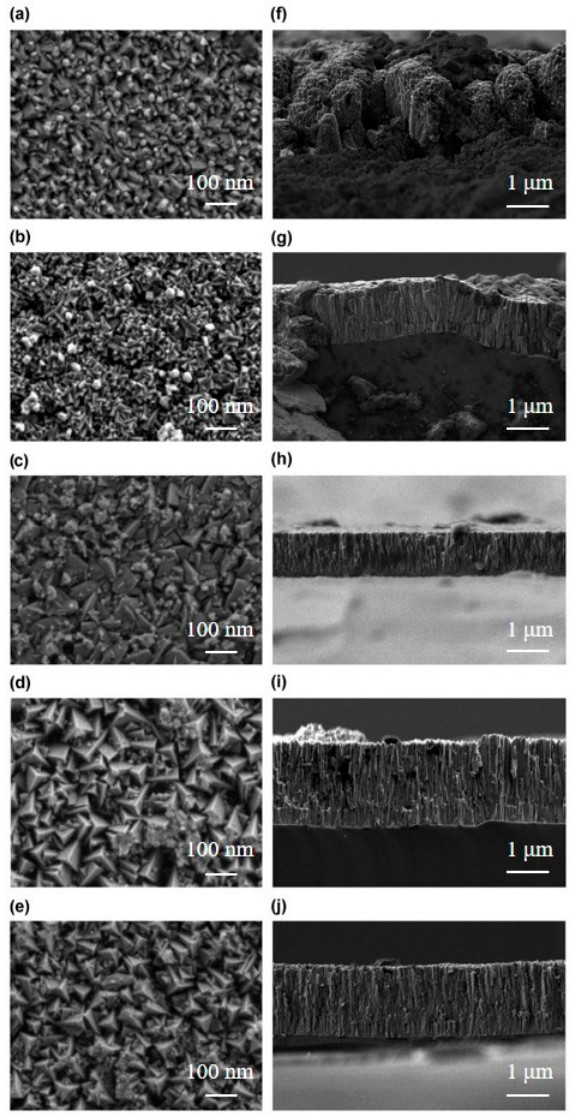
Figure 1. Surface and cross-sectional morphologies of the CrAgCeN coatings formed under different pressures of the sputtering gas: ( a,f ) 0.4 Pa, ( b,g ) 0.5 Pa, ( c,h ) 0.6 Pa, ( d,i ) 0.7 Pa and ( e,j ) 0.8 Pa. pressures of the sputtering gas: ( a , f ) 0.4 Pa, ( b , g ) 0.5 Pa, ( c , h ) 0.6 Pa, ( d , i ) 0.7 Pa and ( e , j ) 0.8